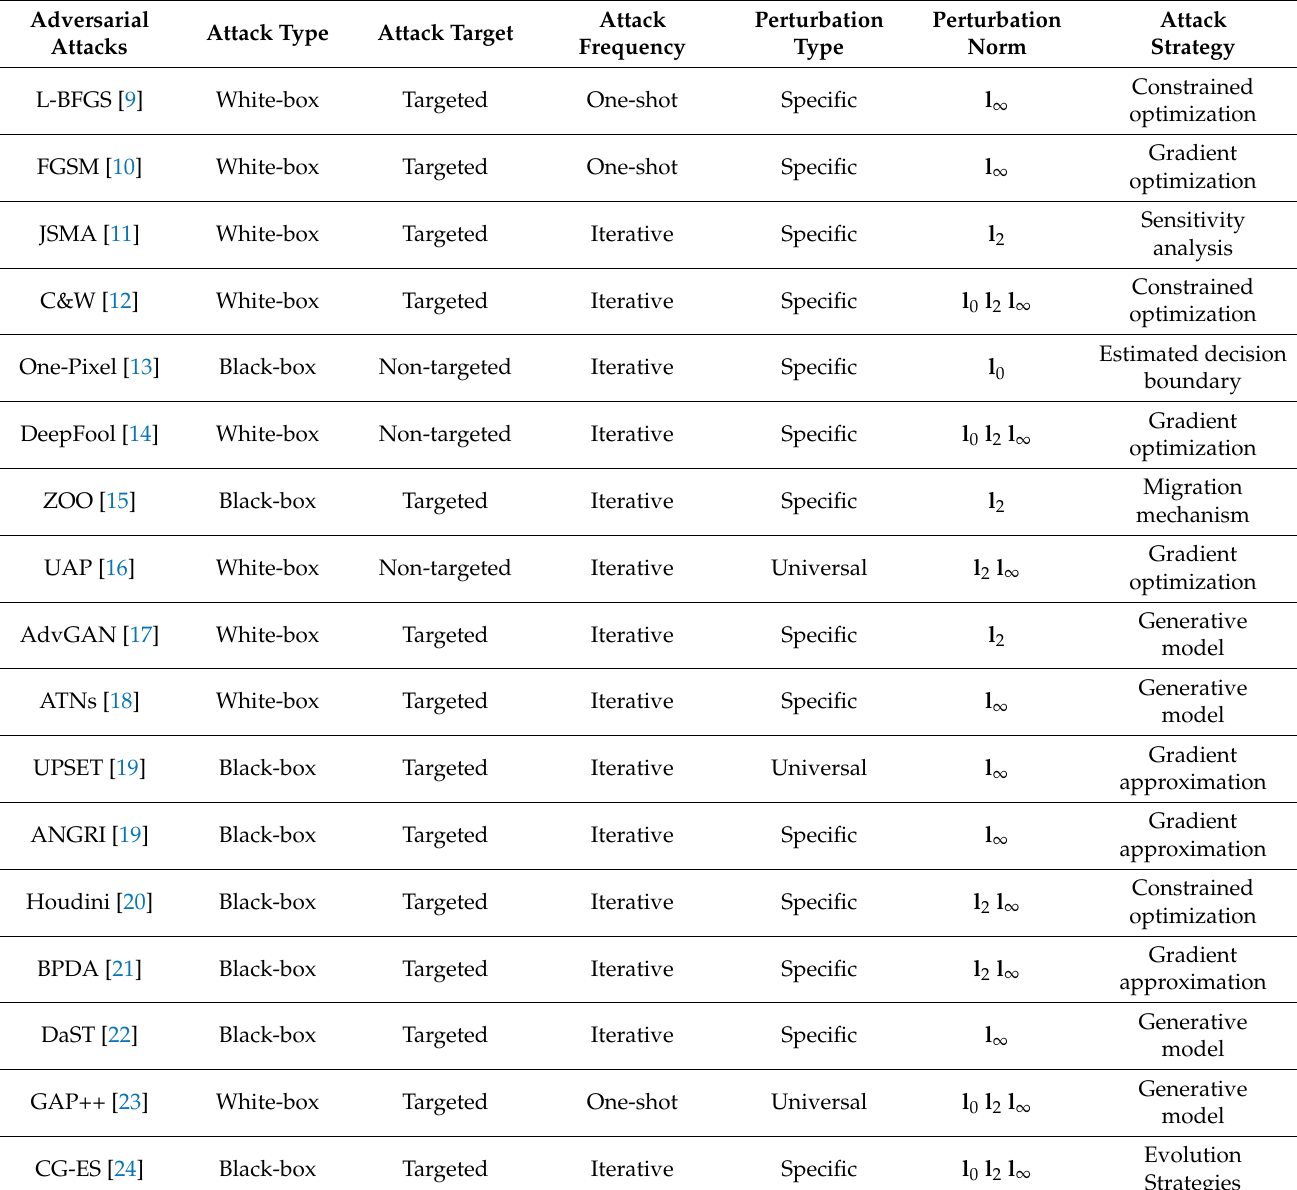
Table 1. Summary of typical adversarial attack and its